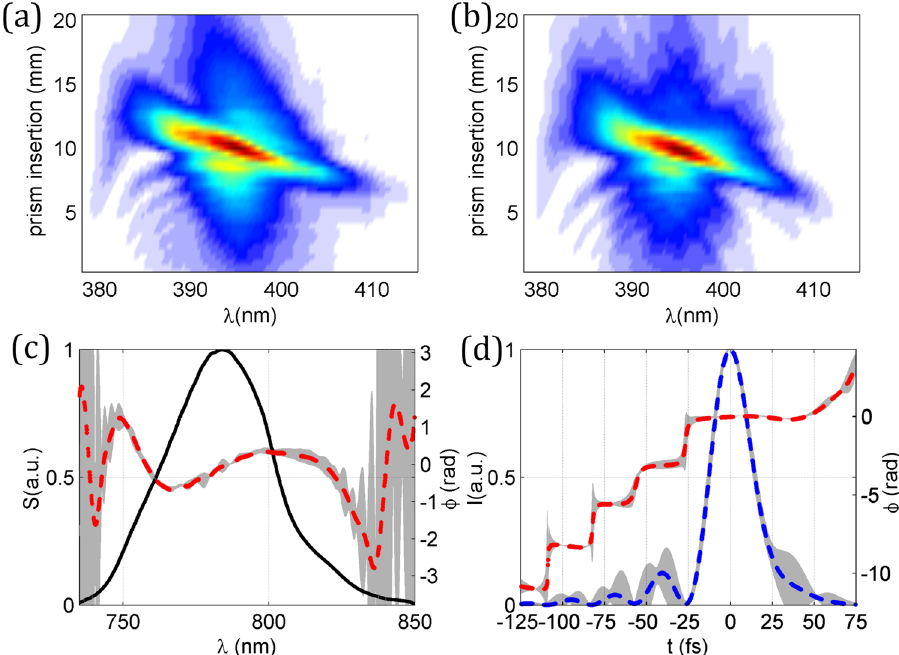
Figure 5. Results of the CPA laser pulses measured with self-calibrated d-scan. ( a ) Experimental and ( b ) retrieved self-calibrated d-scan traces. ( c ) Spectrum of the pulse (solid black curve) and retrieved phase (dashed red curve), ( d ) temporal intensity (dashed blue curve) and retrieved phase (dashed red curve). Grey shaded areas denote the error (magnified 10 times) in the retrievals, calculated as the standard deviation over 5 independent